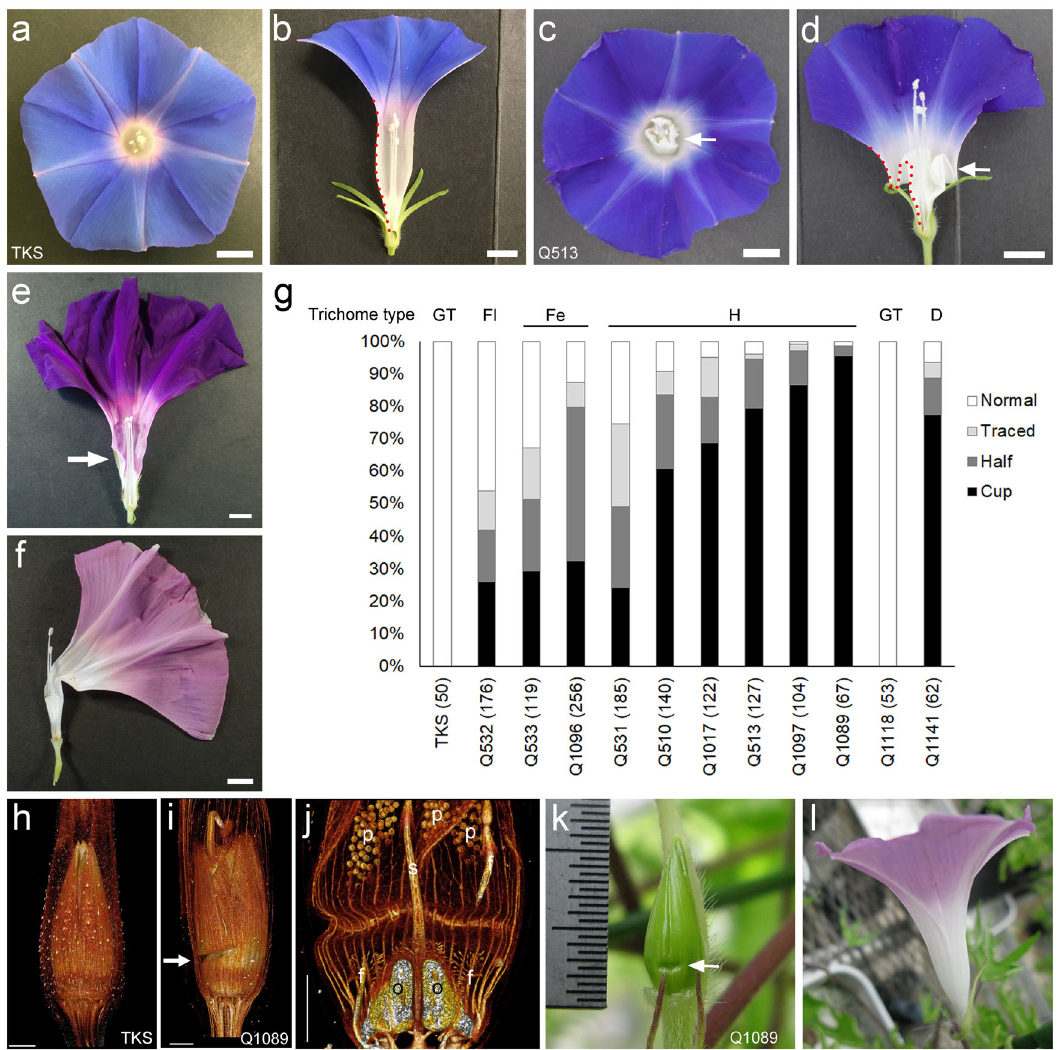
Fig. 1 Corolla folding of cup-shaped fl owers of morning glory. a , b Top ( a ) and side ( b ) views of Tokyo Kokei Standard (TKS) fl owers. c , d Top ( c ) and side ( d ) views of cup fl ower line Q513. The arrows indicate the cylinder-like structures generated by corolla folding. The tube shape is outlined with a red dotted line. e ‘ Traced ’ tube in Q533. f ‘ Half ’ tube in Q1089. g Ratio of corolla defects in cup fl ower lines. The examined fl ower number is shown with the line ID. Types of glandular secretory trichomes on the corolla are shown above the graph (see Fig. 3). GT normal glandular trichome, Fl fl at, Fe few, H hair, and D deformed. h – j 3D constructed image of fl oral buds of TKS and Q1089 from X-ray microcomputed tomography imaging. h TKS. i , j Q1089. The arrow in (i) indicates the cavity. f fi lament, o ovule, p pollen, s style. k , l Sepal removal at the early stage restored the straight elongation of the corolla. The arrow in k indicates the cavity on the corolla surface. Scale bars: a – f 1 cm: h – j 1